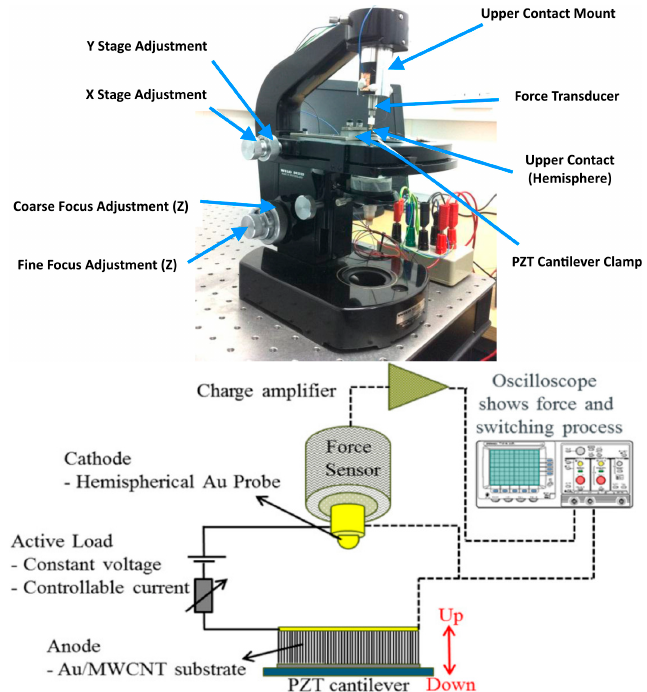
Figure 3. Switching circuit arrangement and experimental apparatus [23].